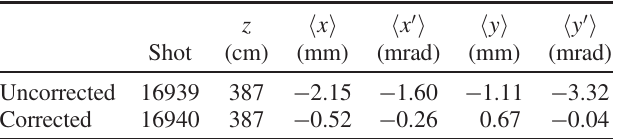
TABLE I. Measured beam centroid correction after 4 cells at